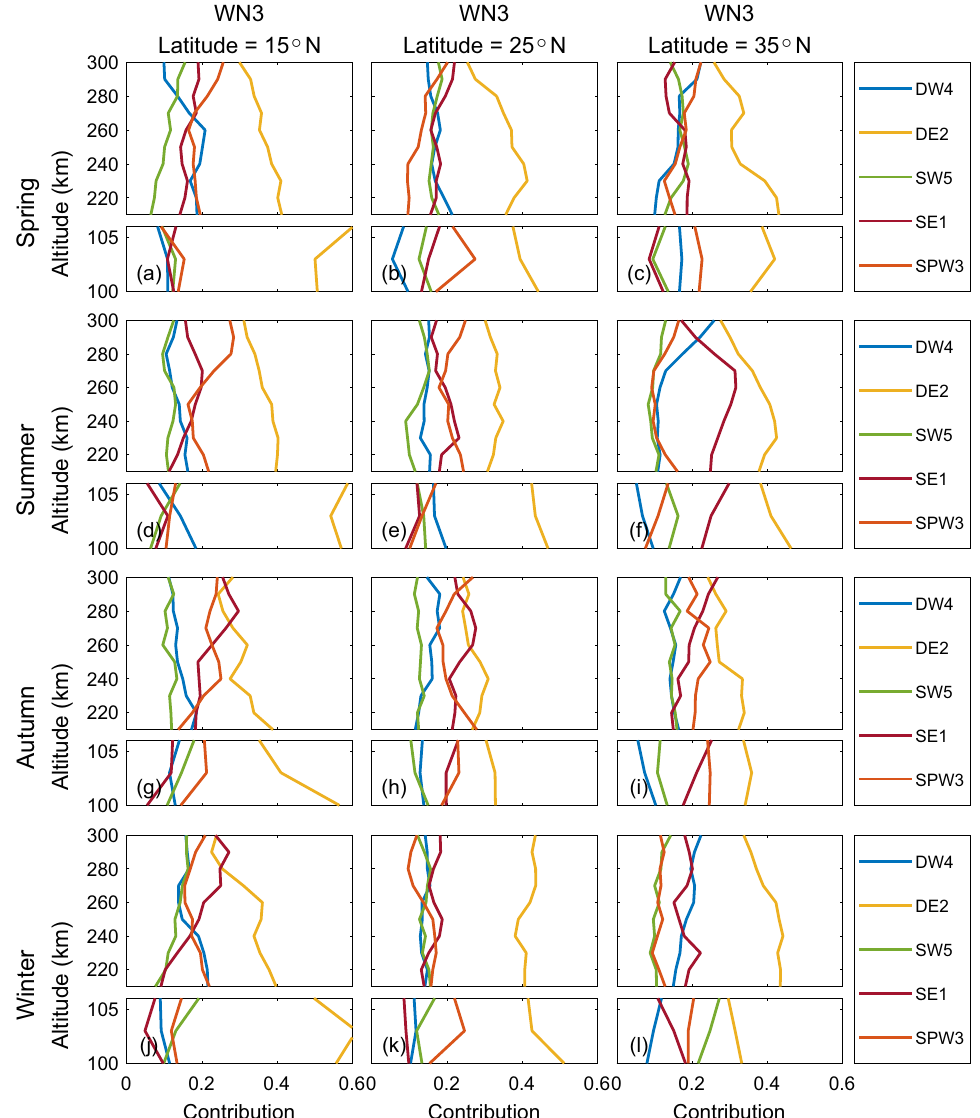
Fig. 6 Same as Fig. 4, but shows the contribution of potential sources to WN3, the blue, yellow, green, purple and orange line represent DW4, DE2, SW5, SE1 and SPW3,